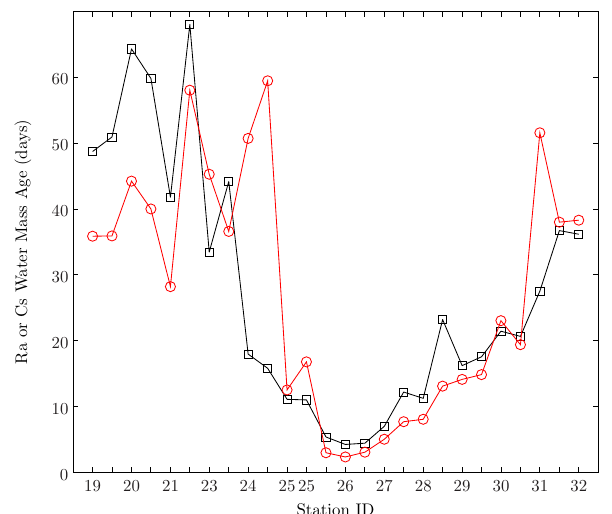
Fig. 7. Radium water mass age (black) and oceanographic-model- based water Cs age (black) at each station. The Cs age is defined as the transit time from the Fukushima NPP to the station of interest at the time of each station occupation during the